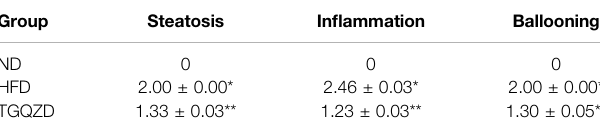
TABLE 3 | Average score of histopathological fi ndings in livers ( (cid:1) x ± s , n = 6 ). Group Steatosis In fl